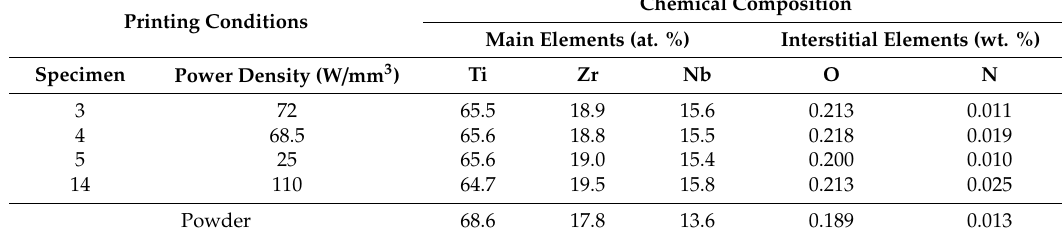
Table 3. Chemical compositions of the Ti-Zr-Nb powder and selected printed specimens.